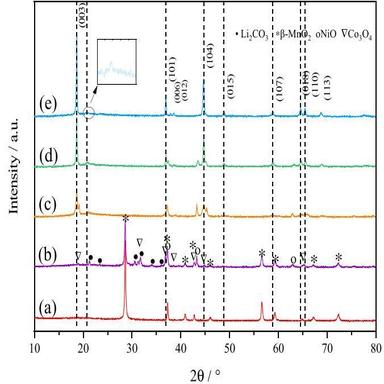
XRD patterns of self-made MnO2 (a), raw mixture (b) and the synthesized samples at 550 ℃ for 5 h (c), 850 ℃ for 12 h (d) and 850 ℃ for 24 h (e).